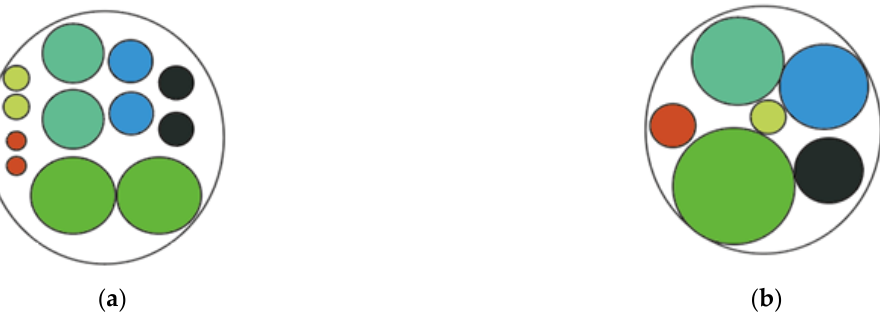
Figure 2. Theoretical diagram of original particle size distribution ( a ) and amplified particle size distribution ( b ). distribution ( b